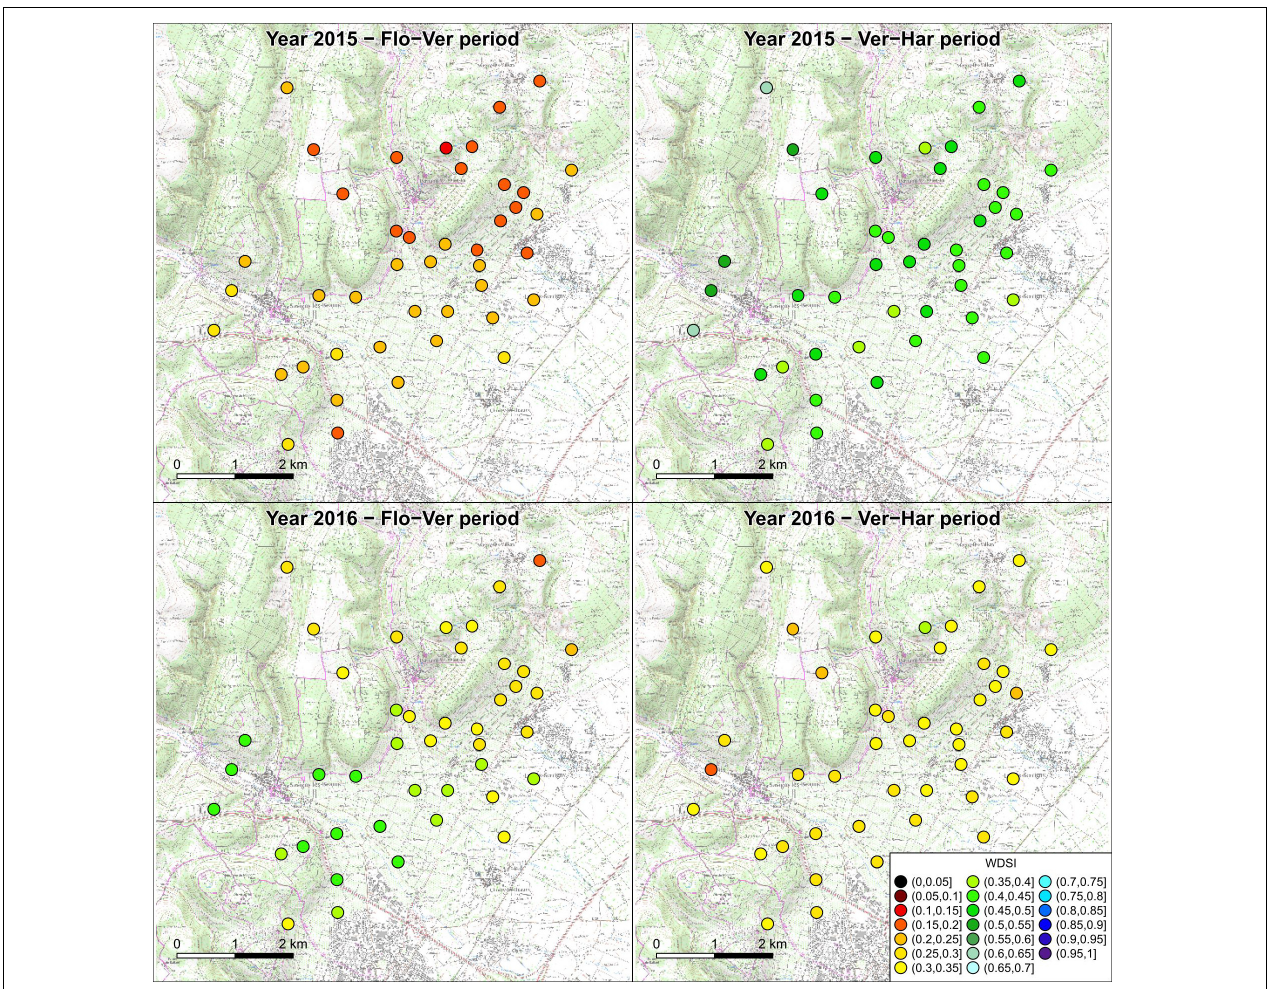
FIGURE 5 | Maps of the average WDSI calculated using a 50-mm WHC soil during two grapevine development stages (Flo–Ver, flowering to veraison; Ver–Har, veraison to harvest) in 2015 and 2016. Each point corresponds to a rain gauge of the Hydravitis local scale